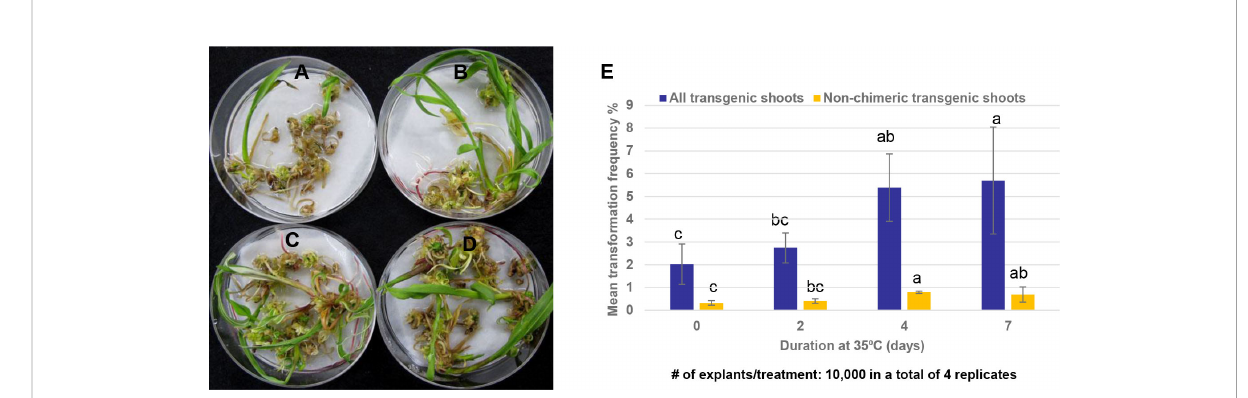
FIGURE 7 Effect of temperature on shoot bud formation. (A) Transgenic shoot regeneration when 1 st bud induction was conducted at 28°C for 7 days; (B) Transgenic shoot regeneration when SEEs were initially cultured at 35°C for 2 days before transfer to 28°C for an additional 5 days on 1 st bud induction; (C) Transgenic shoot regeneration when SEEs were initially cultured at 35°C for 4 days before transferring to 28°C for additional 3 days on 1 st bud induction (D) Transgenic shoot regeneration when SEEs were initially cultured at 35°C for 7 days on 1 st bud induction; (E) Culturing SEEs at 35°C for 4-7 days at the 1 st bud induction increased both the overall transformation frequency (TF) and the transformation frequency of non-chimeric